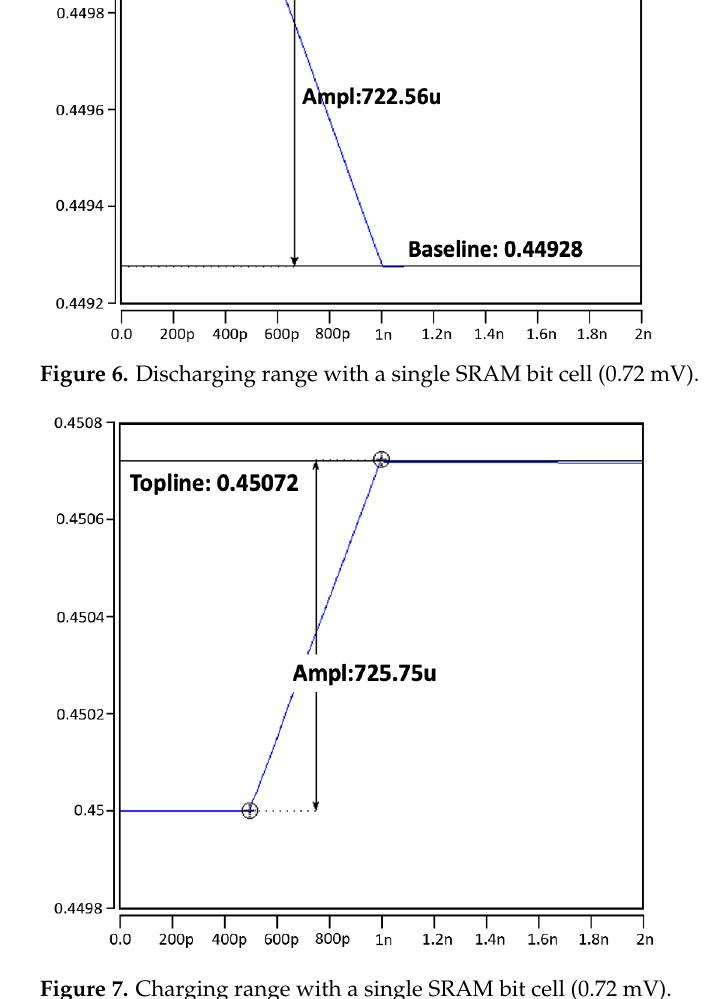
Figure 7. Charging range with a single SRAM bit cell (0.72